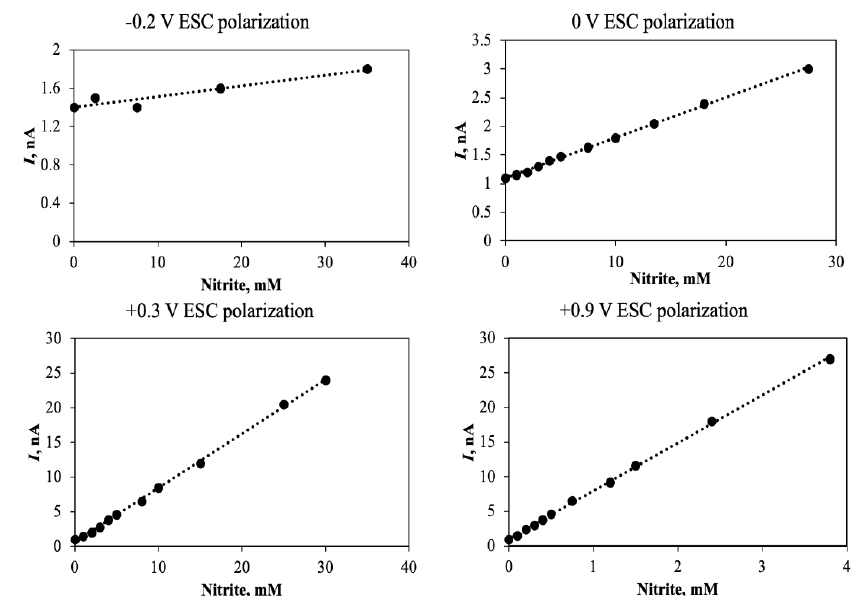
Figure 6. Calibration curves of a NO 2 − biosensor polarized at various ESC potentials. A potentiostat as shown in Figure 5 was not applied for this experiment, but the calibration curves were still linear, indicating that the current in the ESC circuit was constant during the recording of each calibration curve that required about 1 h. (data obtained from the laboratory of the authors).